Question: What form of chart is displayed?
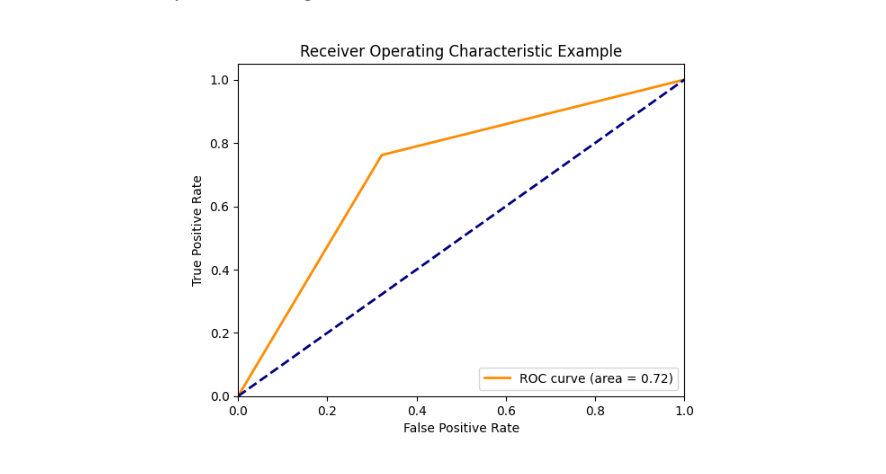
Answer: line